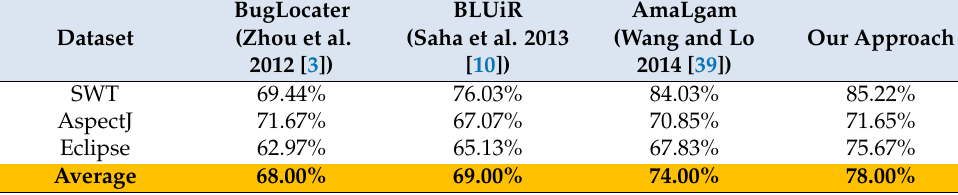
Table 5. Accuracy of different